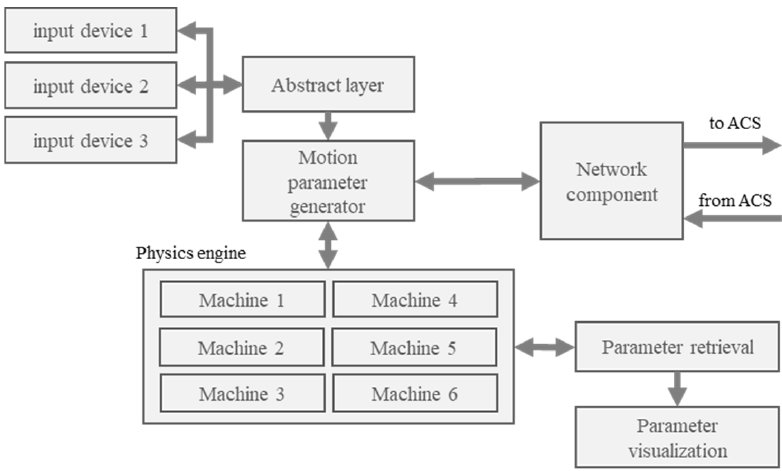
Figure 4. Components and data flow of the machine emulator. Table 2. Parameters used in the machine emulator.